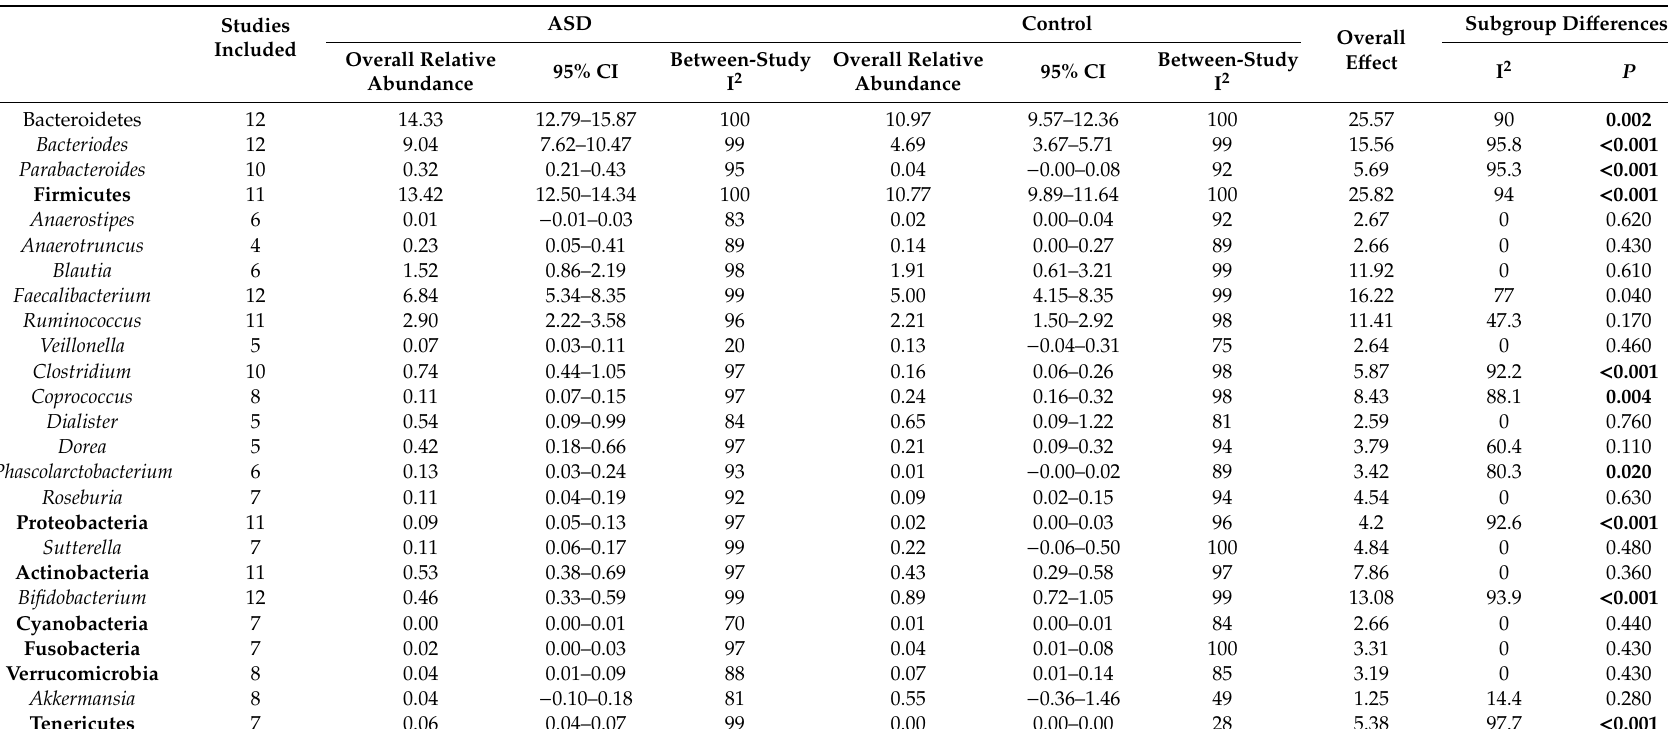
Table 2. Results of the meta-analysis at phylum and genus levels in ASD children and controls, and the significance of the di ff erence between